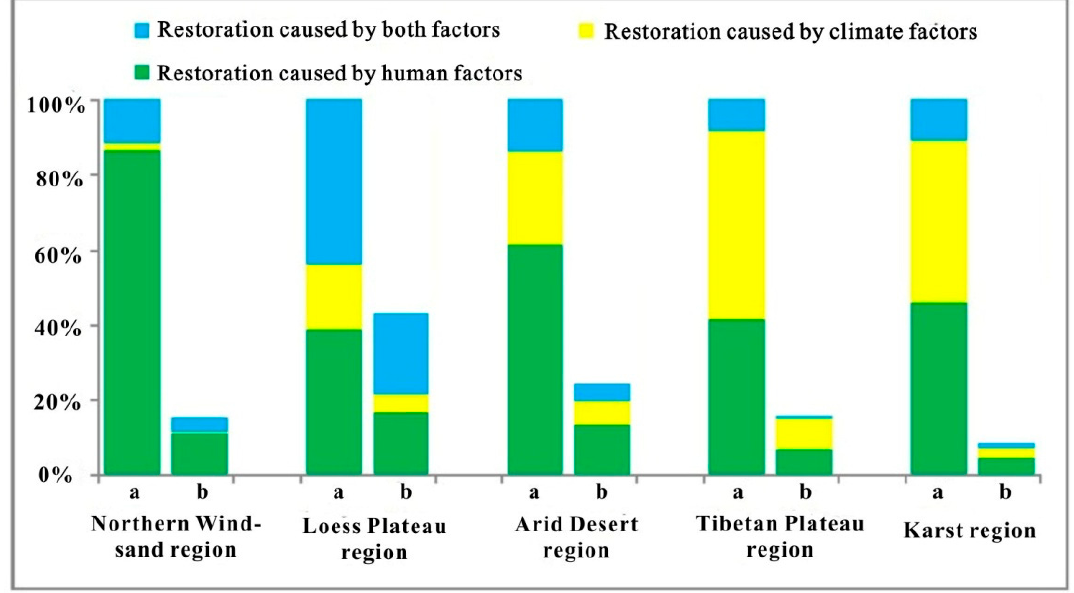
Figure 4. Statistics of vegetation restoration caused by different factors in the whole areas “a” and the NPP a significantly changed areas “b” of five ecologically vulnerable regions from 2000 to